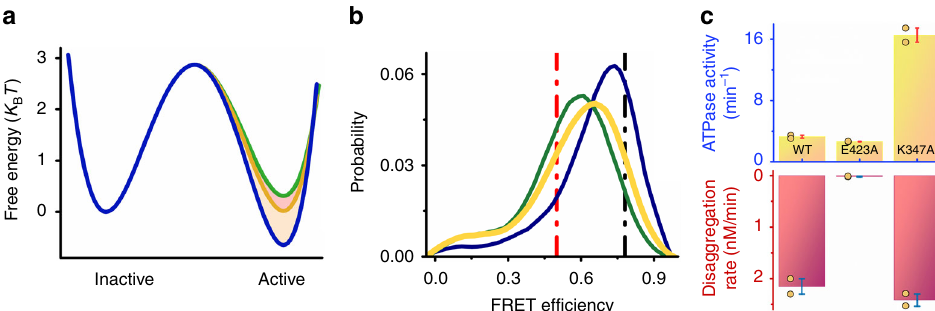
Fig. 5 Mutations that change M-domain dynamics affect ClpB function. a Free-energy pro fi les of the M domain calculated from H 2 MM populations and rates as obtained from analysis of smFRET measurements of the WT (orange), K347A (blue), and E423A (green). In K347A state 1 is stabilized, while in E423A state 1 is destabilized (for all transition rates (in s − 1 ) and their errors see Supplementary Table 4, for the population ratios see Supplementary Table 5). b FRET ef fi ciency histograms of the WT (orange), K347A (blue), and E423A (green). The histogram of K347A is shifted to higher FRET ef fi ciency values, while that of E423A is shifted to lower values. Vertical lines indicate the FRET ef fi ciency values corresponding to state 1 and 2 from H 2 MM analysis of the WT measurement (Fig. 1E). c Steady state ATPase and disaggregation activity of the WT and the two mutants, demonstrating that changes in M- domain dynamics suppress disaggregation activity in E423A, and enhance ATPase activity in K347A. The disaggregation rate is expressed in terms of the concentration of G6PDH recovered per minute. Orange circles in ( c ) represent separate repeats of the measurements. Error bars represent standard errors of the mean. Source data are provided as a Source Data fi